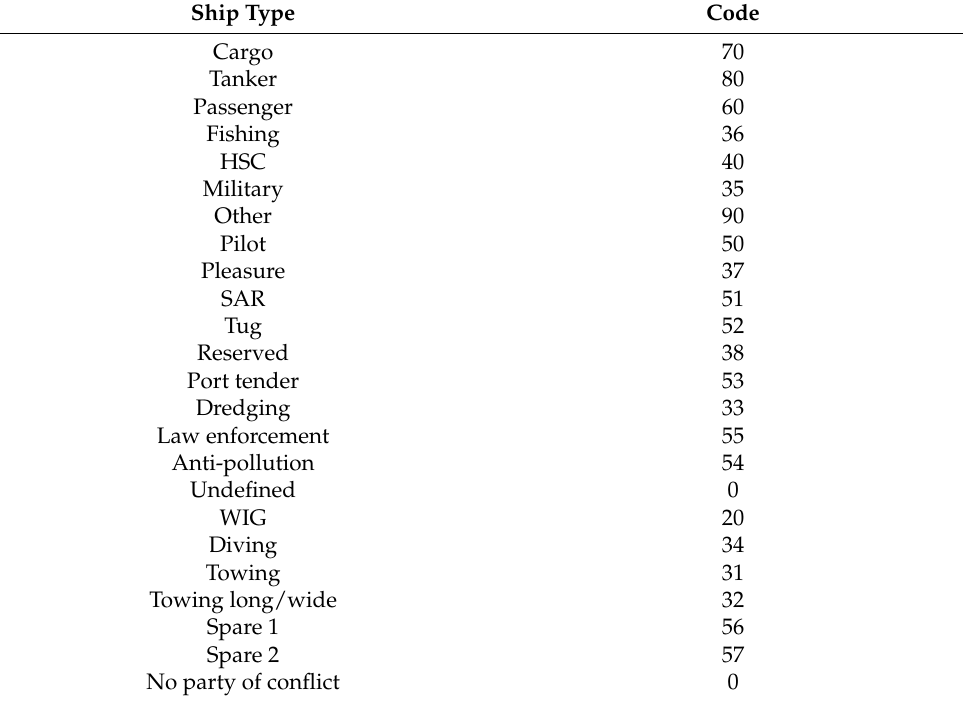
Table 2. Original ship type and substituting codes used in AIS